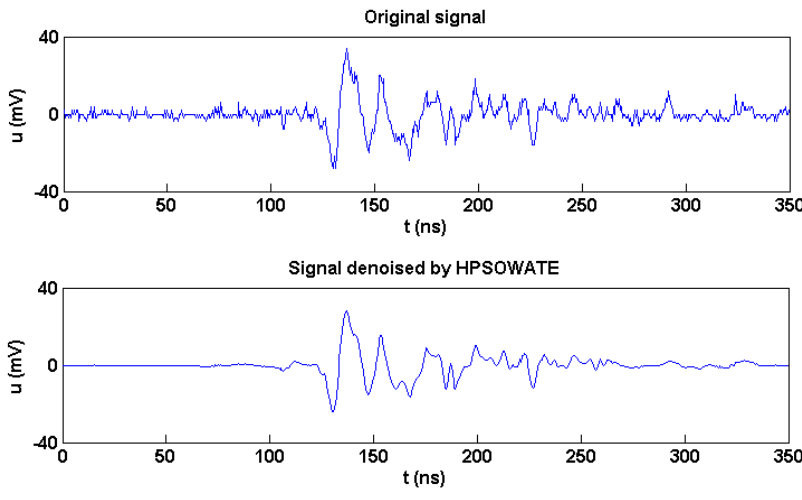
Figure 12. Original signal and de-noised signal of oscillation-attenuated PD pulse.